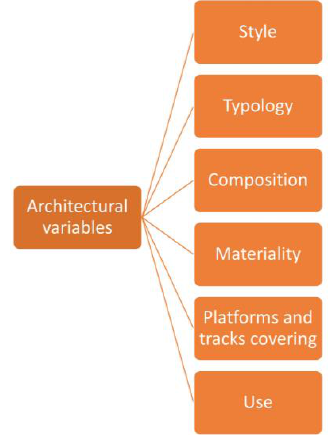
Figure 8. Architectural variables. Own elaboration.